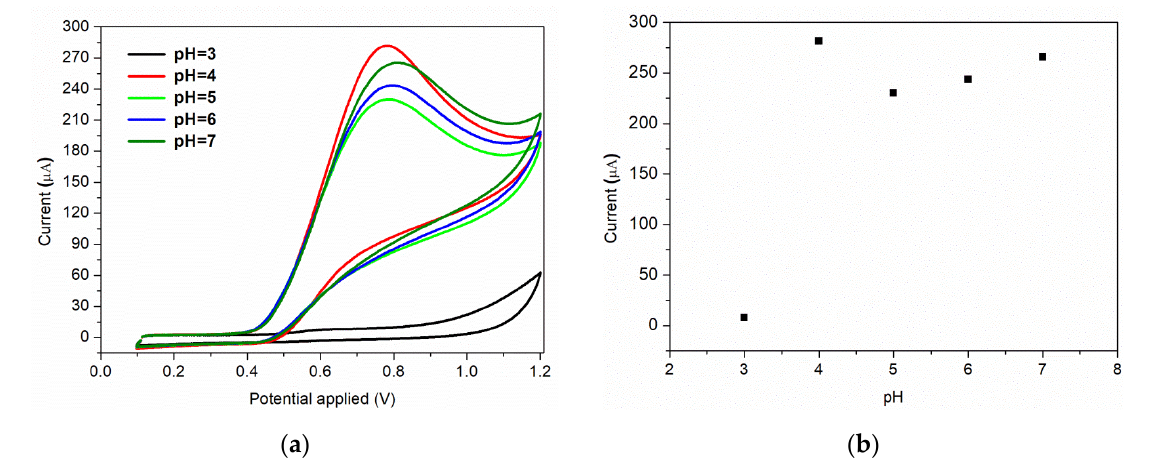
Figure 7. ( a ) Effect of pH of electrolyte on the voltammetric response; ( b ) corresponding plot of peak current vs. pH.